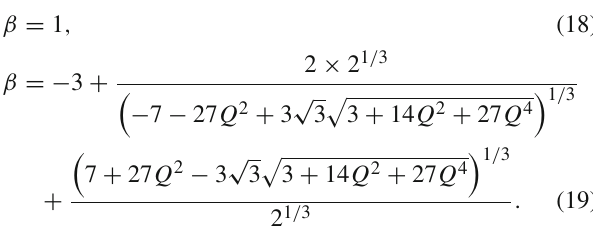
Fig. 1 Plot of Eq. (19), β( Q ) × Q . It is shown that Q = β = 1. Hence, we are interested in values of Q > given by Eq.